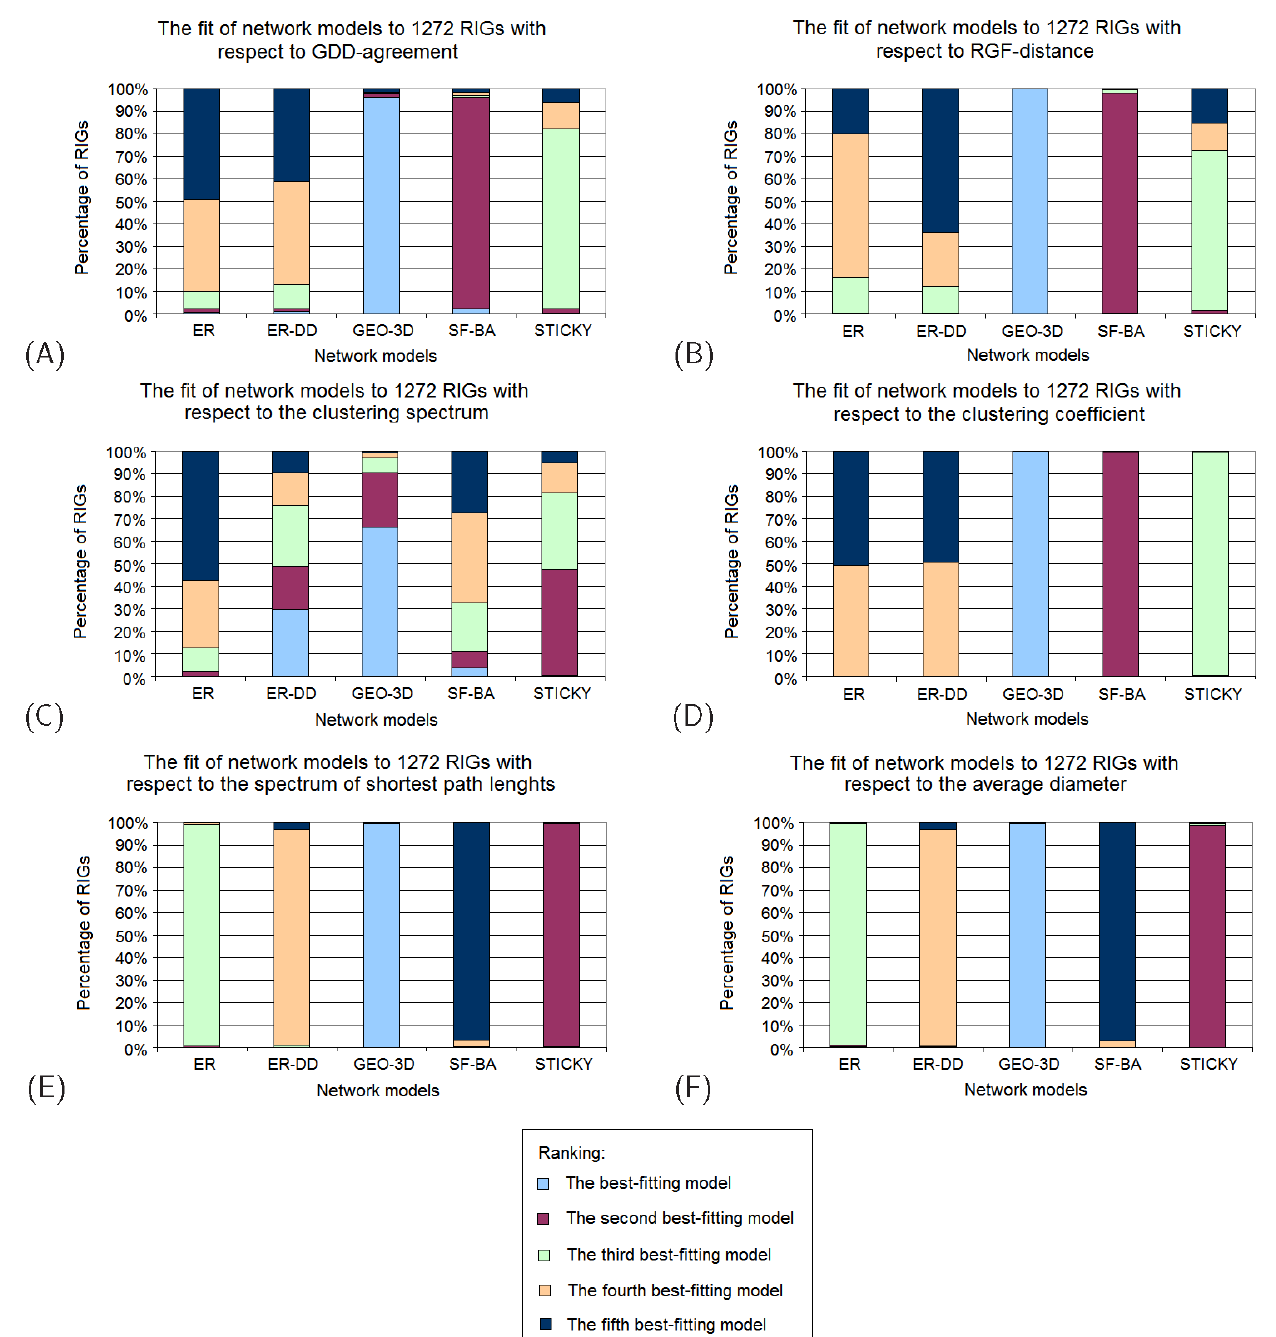
Figure 2. The fit of network models to RIGs in Data Set 2. The ranking of five network models (ER, ER-DD, GEO-3D, SF-BA, and STICKY) for 1,272 RIGs corresponding to the 1,272 proteins, constructed with ‘‘ALL’’ contact type and distance cut-off of 5 A˚. The ranking is based on: (A) GDD- agreements between RIGs and model networks, (B) RGF-distances between RIGs and model networks, (C) agreements between clustering spectra of RIGs and model networks, (D) agreements between clustering coefficients of RIGs and model networks, (E) agreements between spectra of shortest path lengths of RIGs and model networks, and (F) agreements between average diameters of RIGs and model networks. doi:10.1371/journal.pone.0005967.g002 (Figure S1.44 B and C), confirming a previous result by Galzitskaya et al. [37].